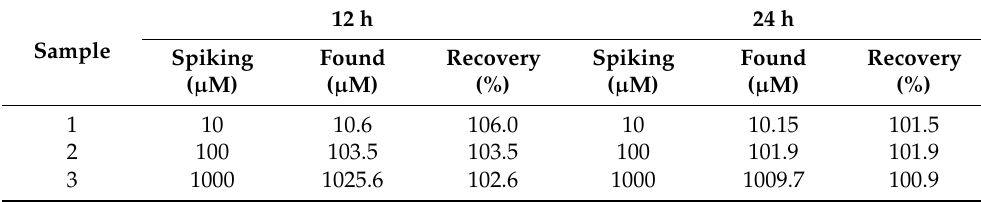
Table 1. Recoveries of the Hx in real fish samples.